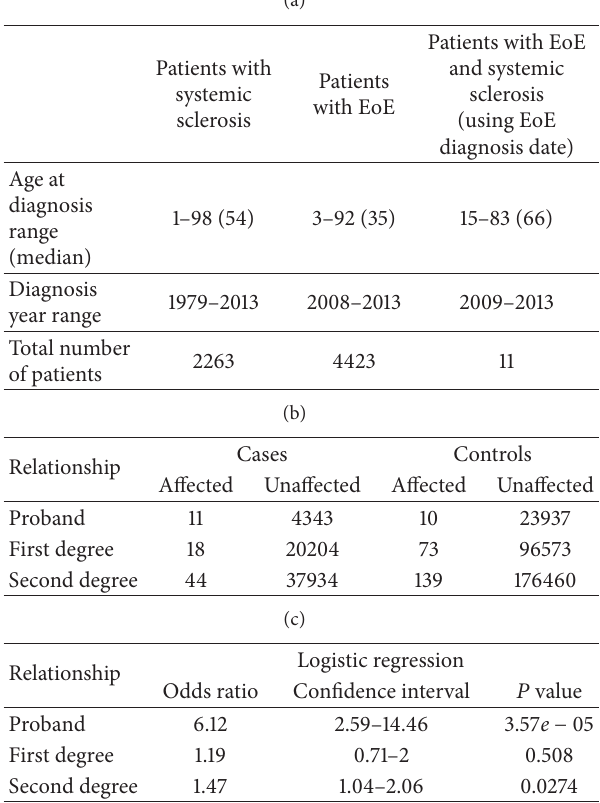
Table 1: Utah population database assessment of eosinophilic esophagitis and systemic sclerosis overlap (a) compared to age and gender matched controls (b) and sorted by heritability